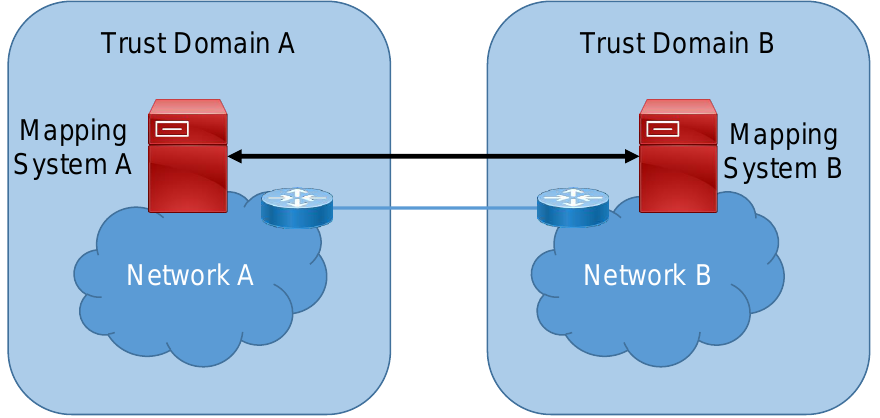
Figure 3. Exchange of routing information between two networks in different administrative domains. The Mapping System is a server that stores overlay-to-underlay mappings, and other network